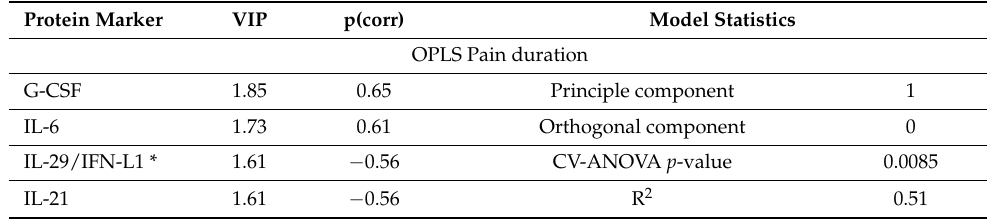
Table 5. OPLS modeling of clinical parameters in temporomandibular disorders myalgia patients. Protein markers are sorted according to VIP-value. * = shared among several OPLS